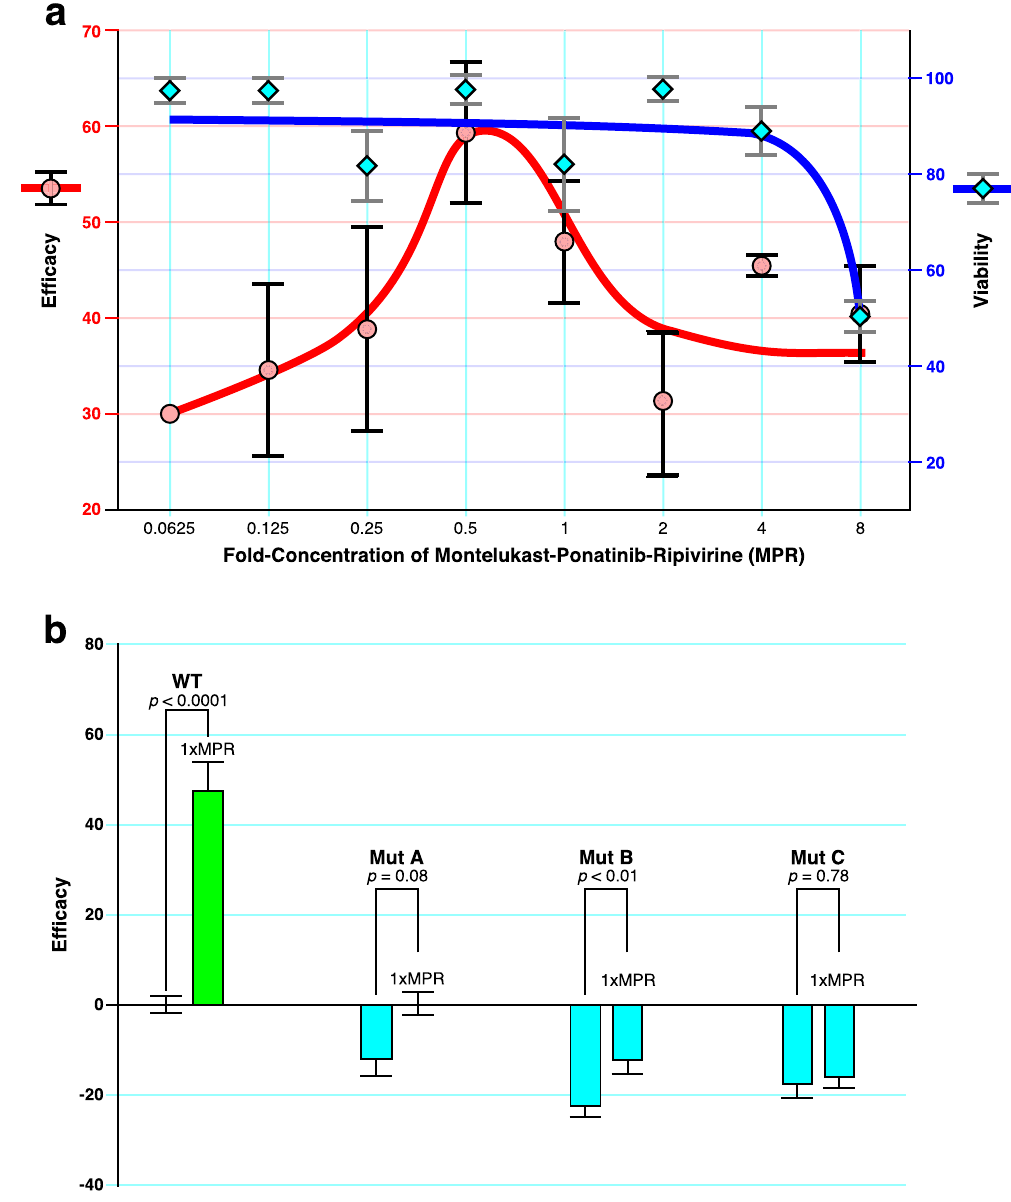
Figure 6. Dose–response of a Montelukast–Ponatinib–Rilpivirine (MPR) Combination. The ratio of Montelukast, Ponatinib, and Rilpivirine (MPR) were fixed such that a 1X concentration = 1.25 µM Montelukast + 0.1 µM Ponatinib + 0.05 µM Rilpivirine. ( a ) Varying concentrations of MPR were added to Nsp1-transfected H1299 cells and Efficacy determined and depicted. Cytotoxicity using the Viability Index in non-transfected H1299 were determined at various concentrations of MPR and depicted on the same graph. ( b ) 1 × MPR was applied to H1299 cells transfected with wild-type (WT) Nsp1 or the indicated Nsp1 mutations (Mut A–C). Error bars represent ± SEM. Statistical significance of treatment with 1xMPR is indicated ( n > 5; p value from a two-sided